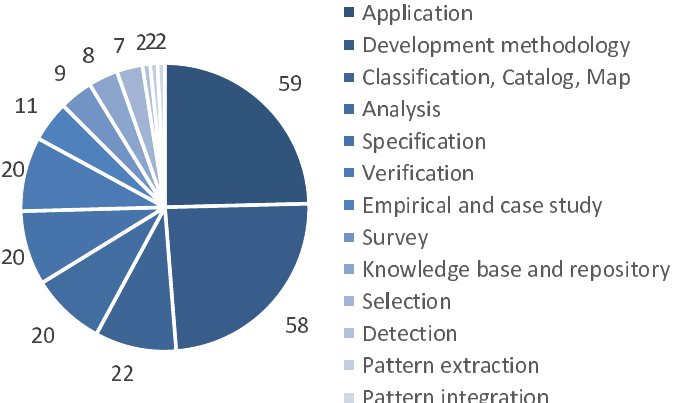
Figure 3. Breakdown of topics (adopted from [247] with updates of